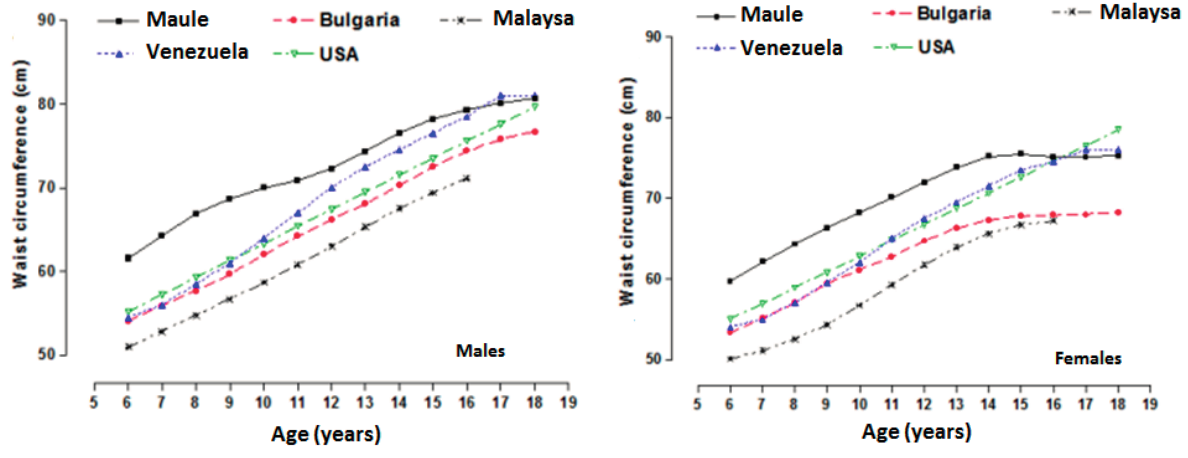
Figure 2. Comparison of the p50 percentile of students of both sexes from the province of Talca (Chile) with other international